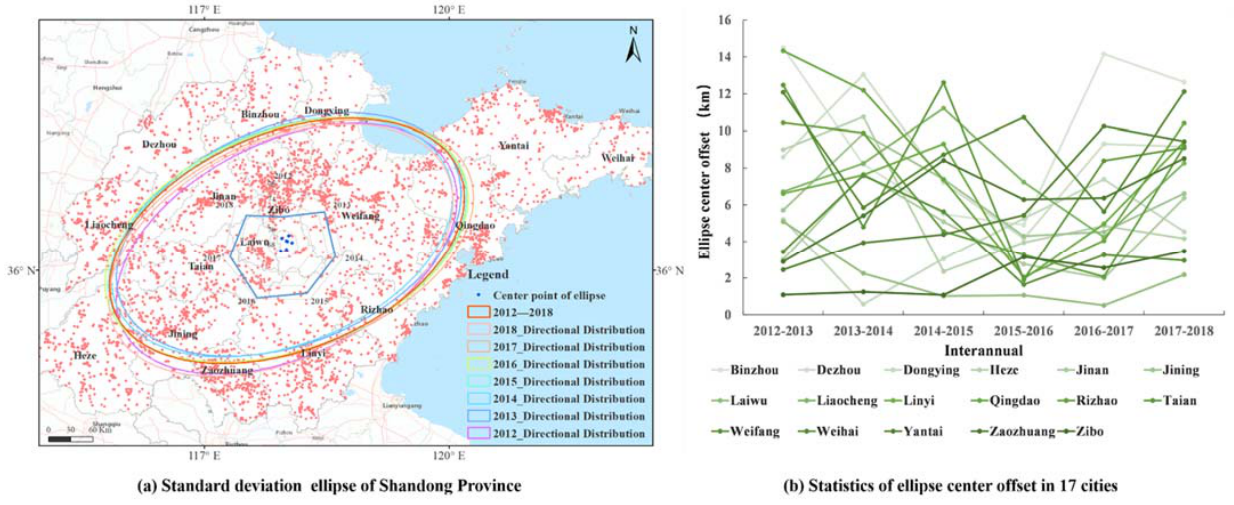
Figure 5. Standard deviation ellipse analysis of Shandong Province ( a ) and statistics of ellipse center offset in 17 cities ( b ) of air pollution complaint data from 2012 to 2018.